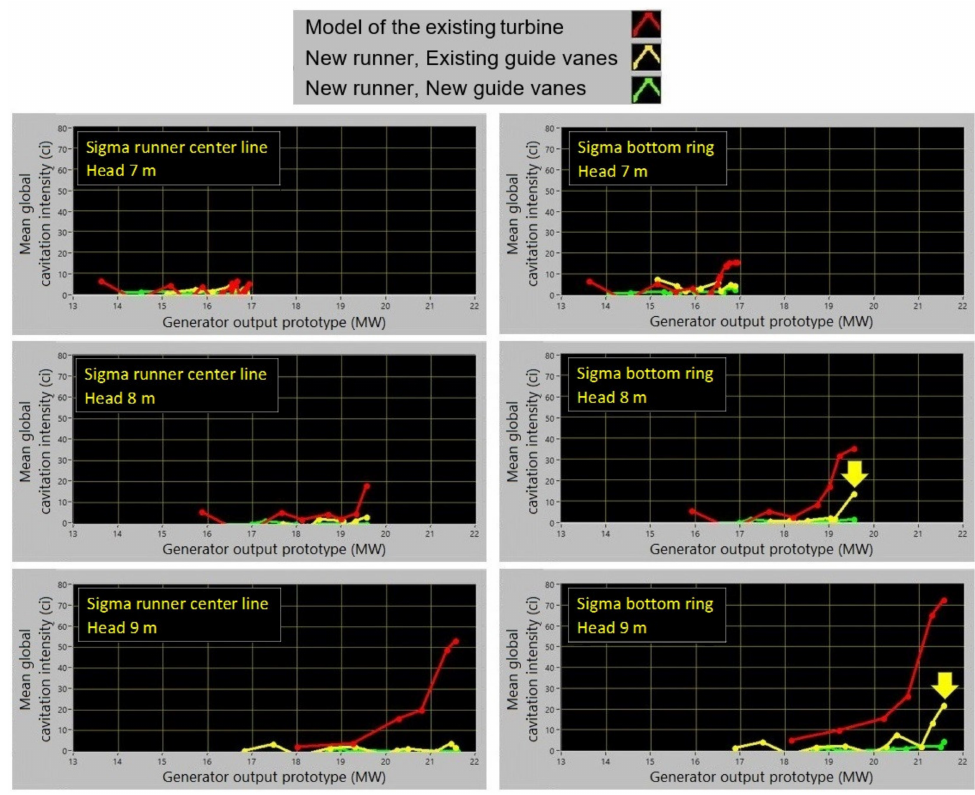
Figure 23. Comparison of the three